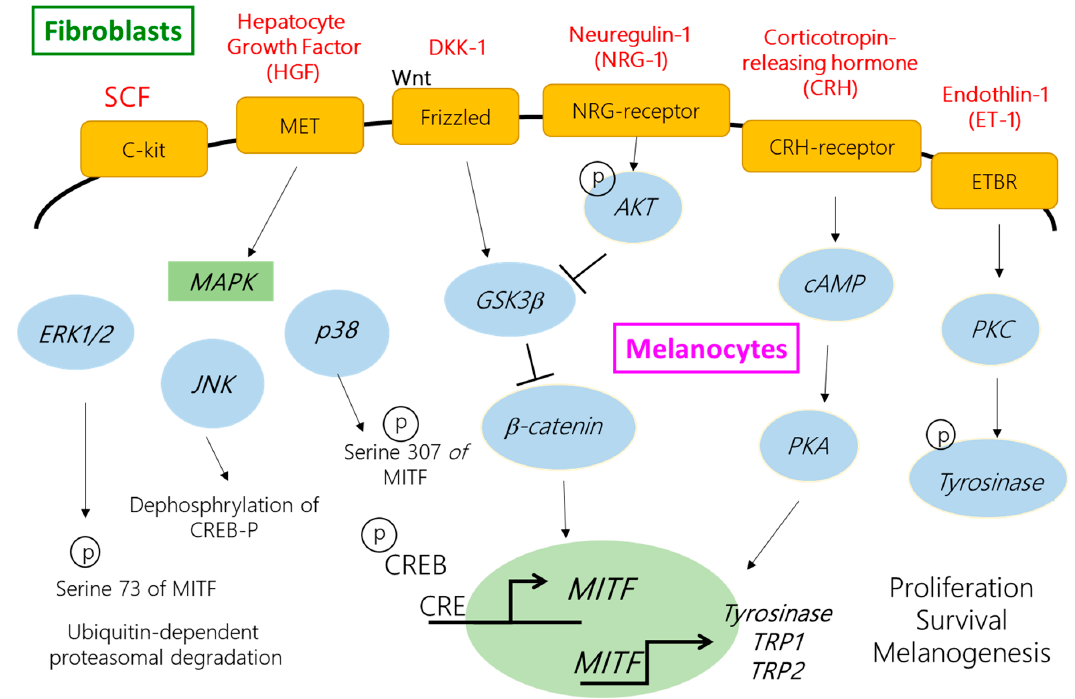
Figure 6. The mRNA pathway of SCF in fibroblasts affects the melanogenesis in